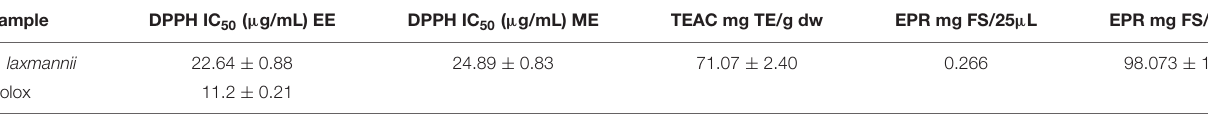
TABLE 6 | DPPH, TEAC, EPR activity of A. laxmannii (mean ± SD). Sample